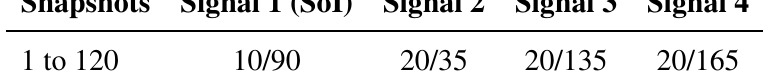
Table 1. Interference and direction of arrival (DoA) scenario, P(dB)relative to the desired User 1/DoA (degree). SoI, signal of